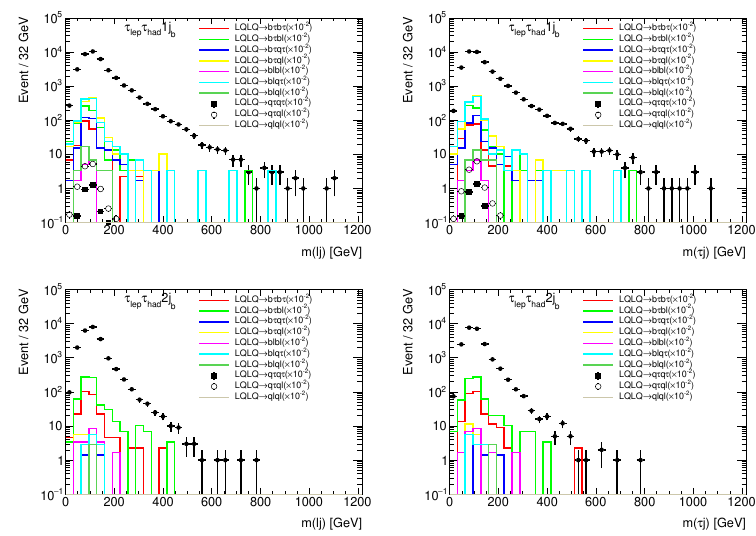
Figure 10 . The distribution of the pair mass of a tau-lepton candidate and its mass-matched jet candidate in the signal region with one b -tagged jet (top) and two b -tagged jets (bottom). The left one is m ( lj ) and the right one is m ( τj ) . The black points represent the data from refs. [56, 95]. The open circles, black squares and histograms represent different signal topologies for a 100 GeV LQ.